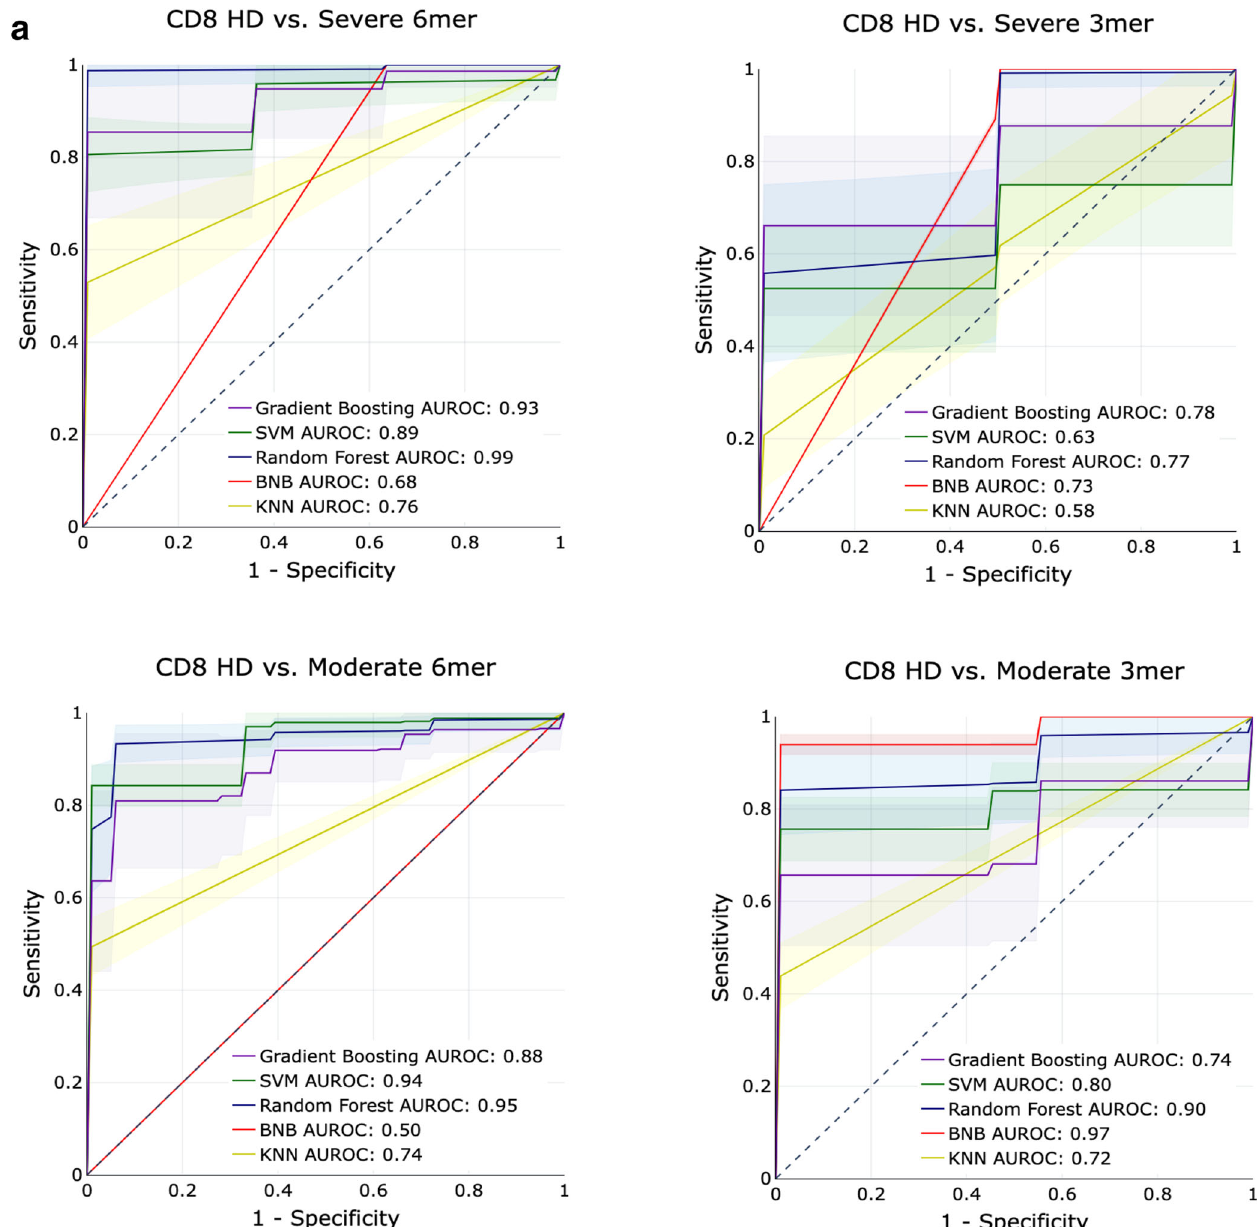
Fig. 5 Predictive performance of machine learning models for disease severity. a AUROC curves for fi ve machine learning models (gradient boosting trees, support vector machines, random forests, Bernoulli Naïve Bayes, and k-nearest neighbors) using 6-mer (left) and 3-mer (right) representations of TCR repertoire data. Models were trained to predict disease severity (moderate, severe) vs healthy donors for CD8 samples. Training and evaluation were performed using 500 iterations per model, average performance + / − 1 standard deviation shown on individual